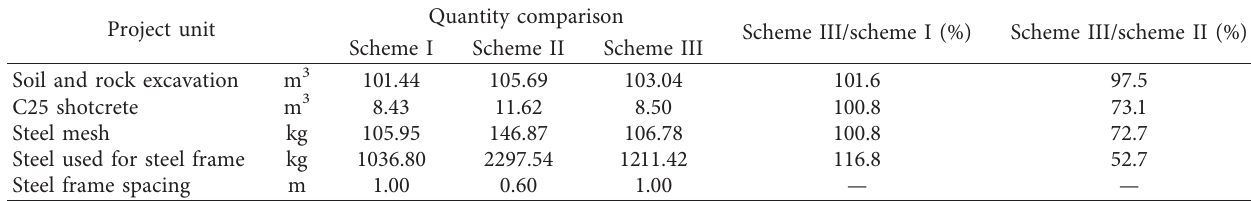
Table 4: Engineering quantity comparison table.